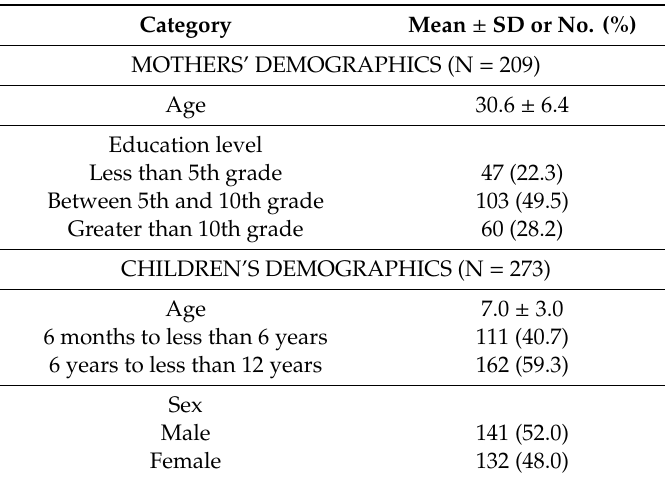
Table 1. Family Demographic